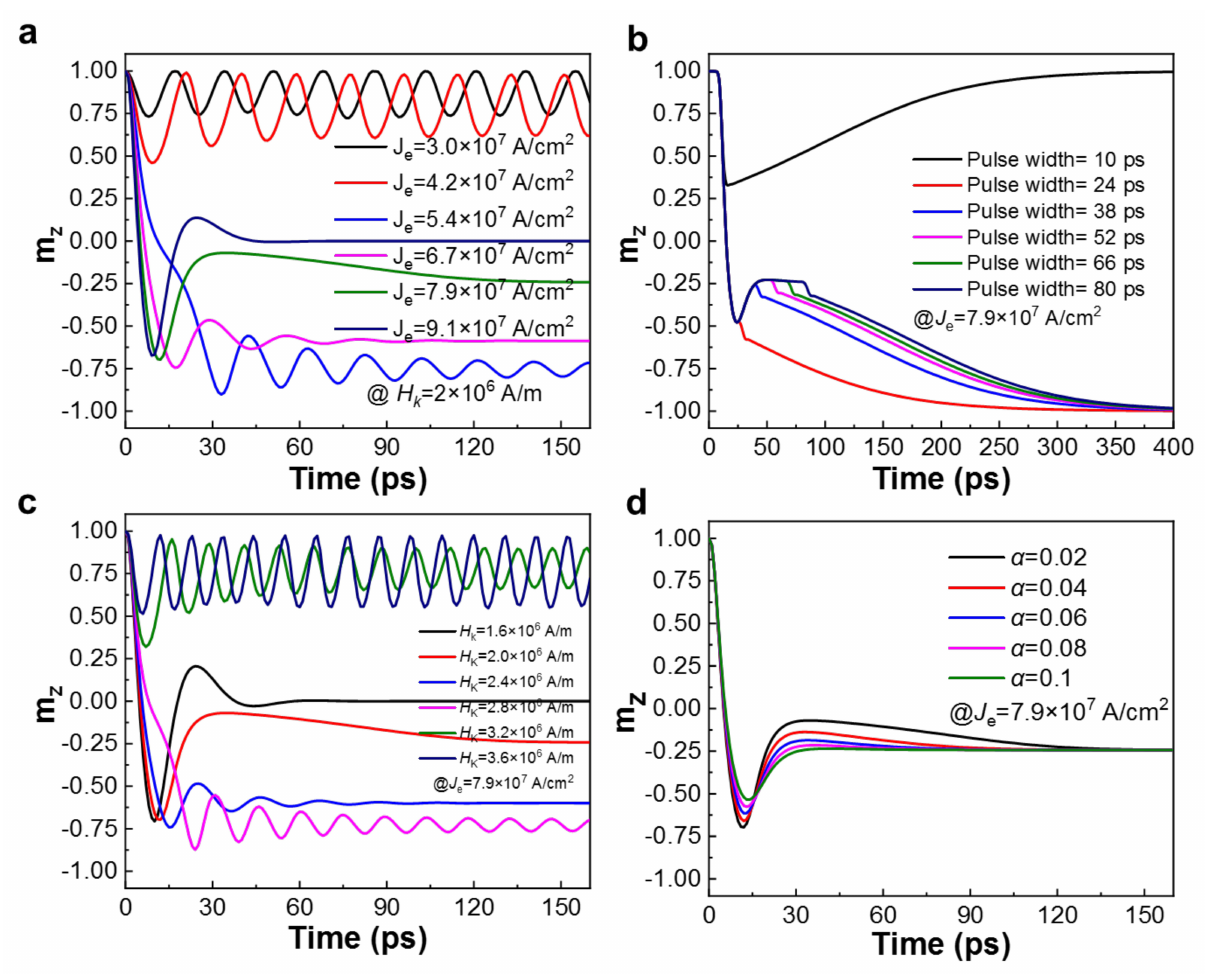
Figure 2. Dependence of magnetization switching of SOT-MTJ on different parameters. The effect of different J e ( a ) and pulse width ( b ) on the magnetization switching. ( c ) The magnetization switching of proposed FGT-MTJ device with various H K and the field-free switching of materials with different Gilbert damping constant ( α ) under J e of 7.9 × 10 7 A/cm 2 ( d